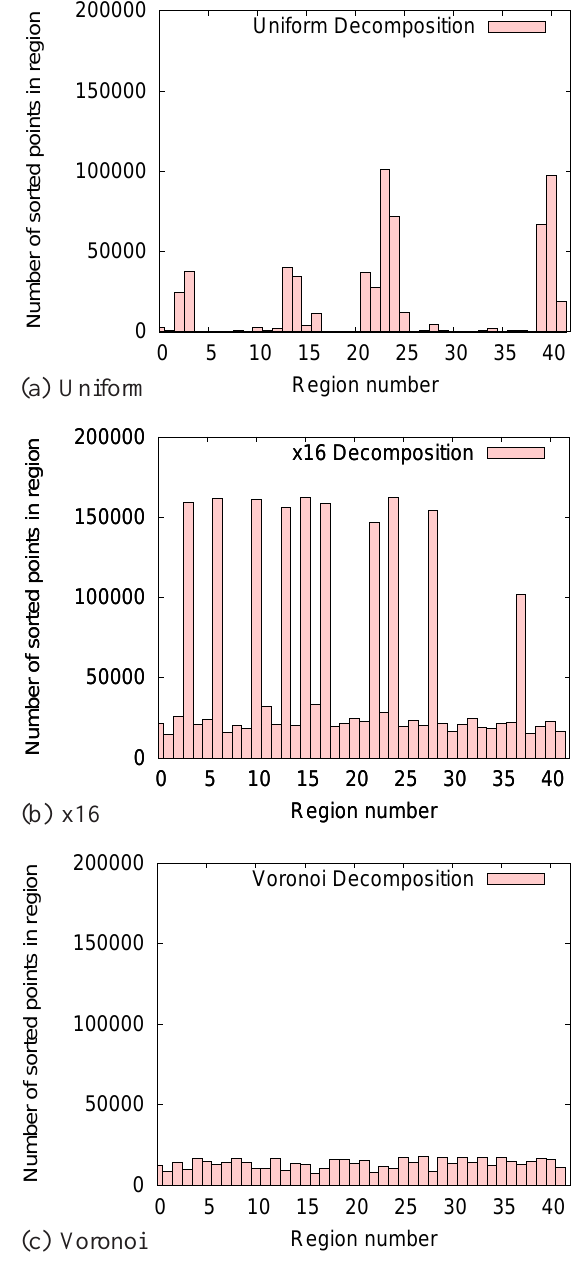
Fig. 3. Number of points each processor has to triangulate. (a) , (b) , and (c) use the sorting approaches corresponding to the three rows of Table 4. All plots were created with the same medium resolution